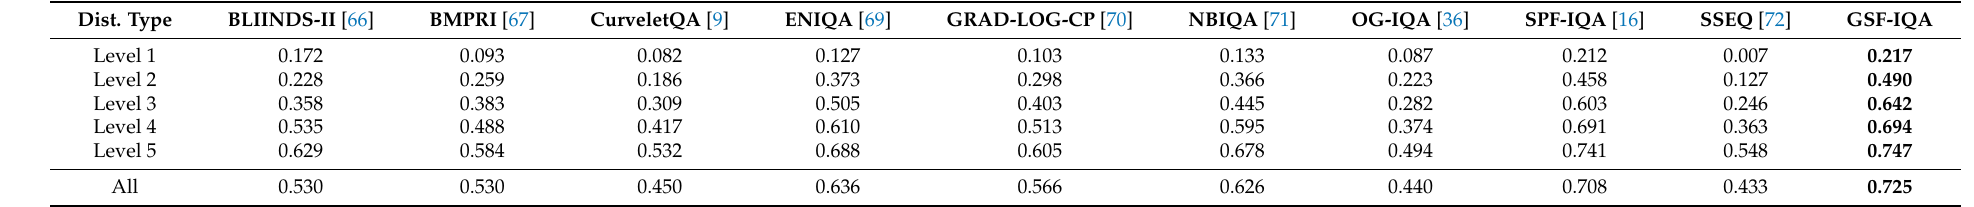
Table 10. Mean SROCC value comparison on different distortion levels of the KADID-10k [46] database. Measured over 100 random train–test splits with respect to the reference images. The best results are typed in